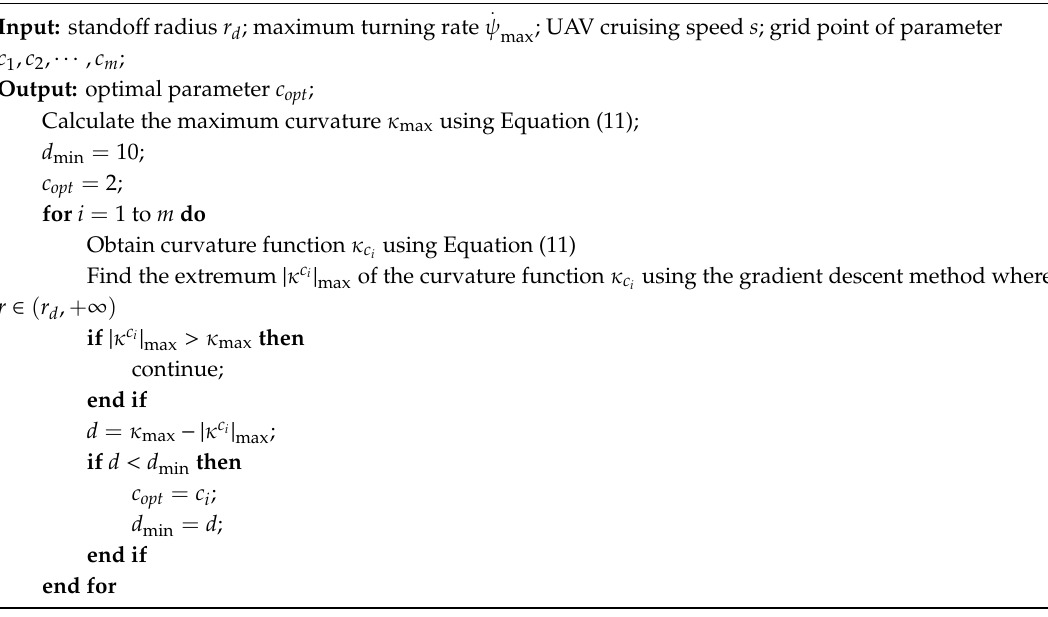
Algorithm 1: Optimal Guidance Parameter